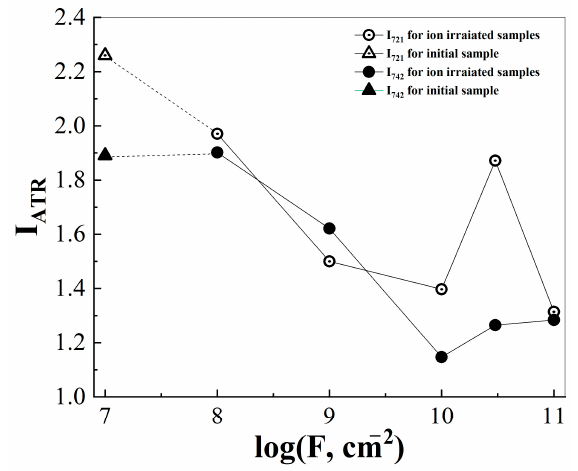
Figure 5. Change in the intensity of vibrational modes 721, 742 cm − 1 in the infrared spectrum of the disturbed total internal reflection of thermoradiationally modified polytetrafluoroethylene depending on the fluence of xenon ions with an energy of ~1 MeV/nucleon.